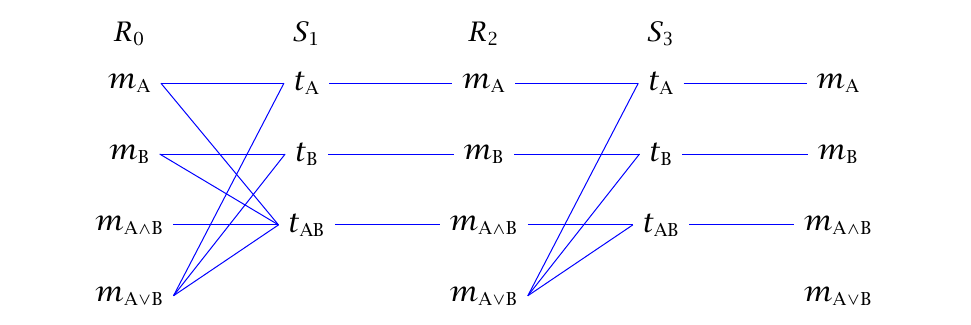
Figure 11 Predictions for plain disjunctions with conjunctive